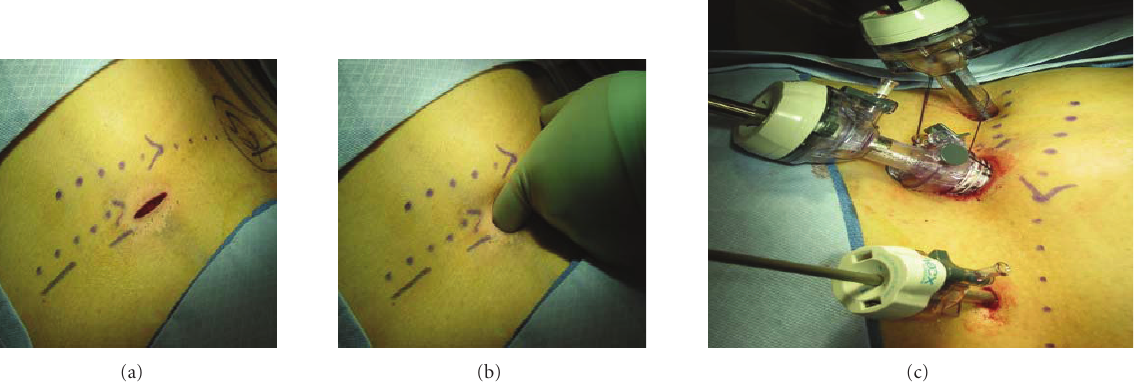
Figure 1: (a) Access for a right retroperitoneal laparoscopic radical nephrectomy (LRN). A 10- to 15-mm incision is made below and medial to the tip of the 12th rib. (b) The flank muscles are pierced with a blunt-tipped instrument followed by finger dissection and development of the retroperitoneum space to permit trocar placement. (c) Trocar placement for a right retroperitoneal LRN.